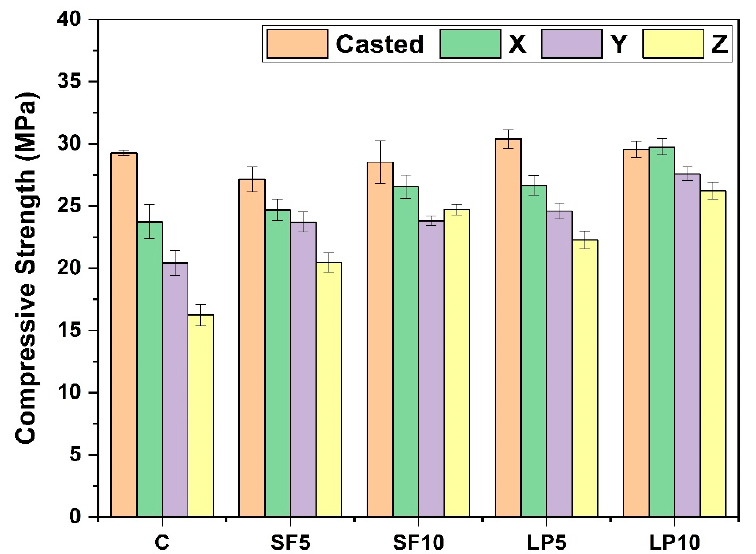
Figure 9. 28-day compressive strength of cast and printed specimens (C = control specimen and X, Y, Z directions are meant for only 3D printed specimens).